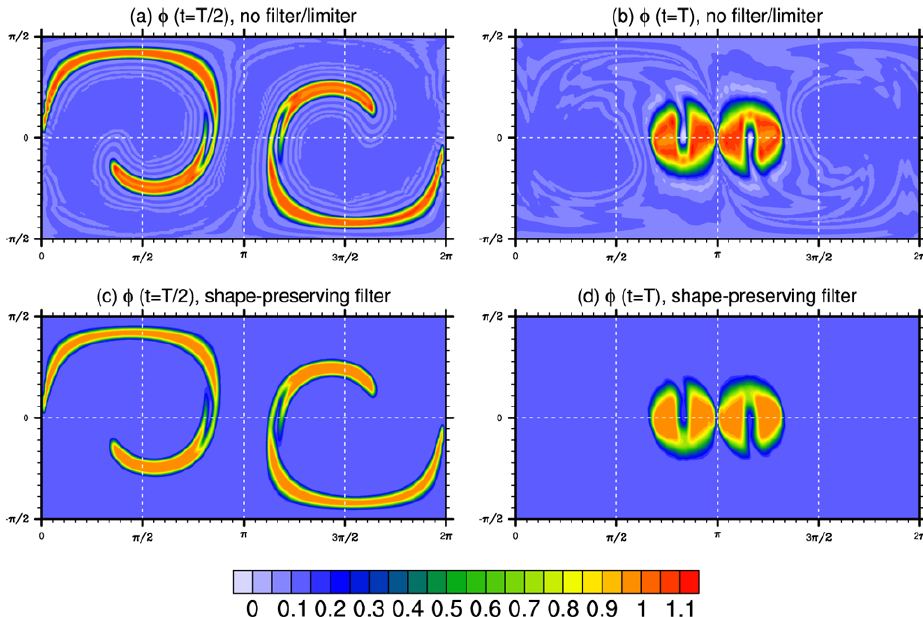
Fig. 7. Contour plot of the CSLAM numerical solution φ at resolution 1λ = 1 . 5 ◦ and time step T/ 120 using the slotted-cylinders initial condition at time t = T/ 2 ( a and c ) and t = T ( b and d ) using no filter/limiter (a and b) and a shape-preserving filter ( c and d ). The standard error norms for the unfiltered/unlimited solution are ‘ 2 = 0 . 24, ‘ ∞ = 0 . 79, φ min = − 0 . 19, and φ max = 0 . 15, and for the shape-preserving solution they are ‘ 2 = 0 . 26, ‘ ∞ = 0 . 80, φ min = 0 . 0, and φ max = − 4 . 34 × 10 − 3